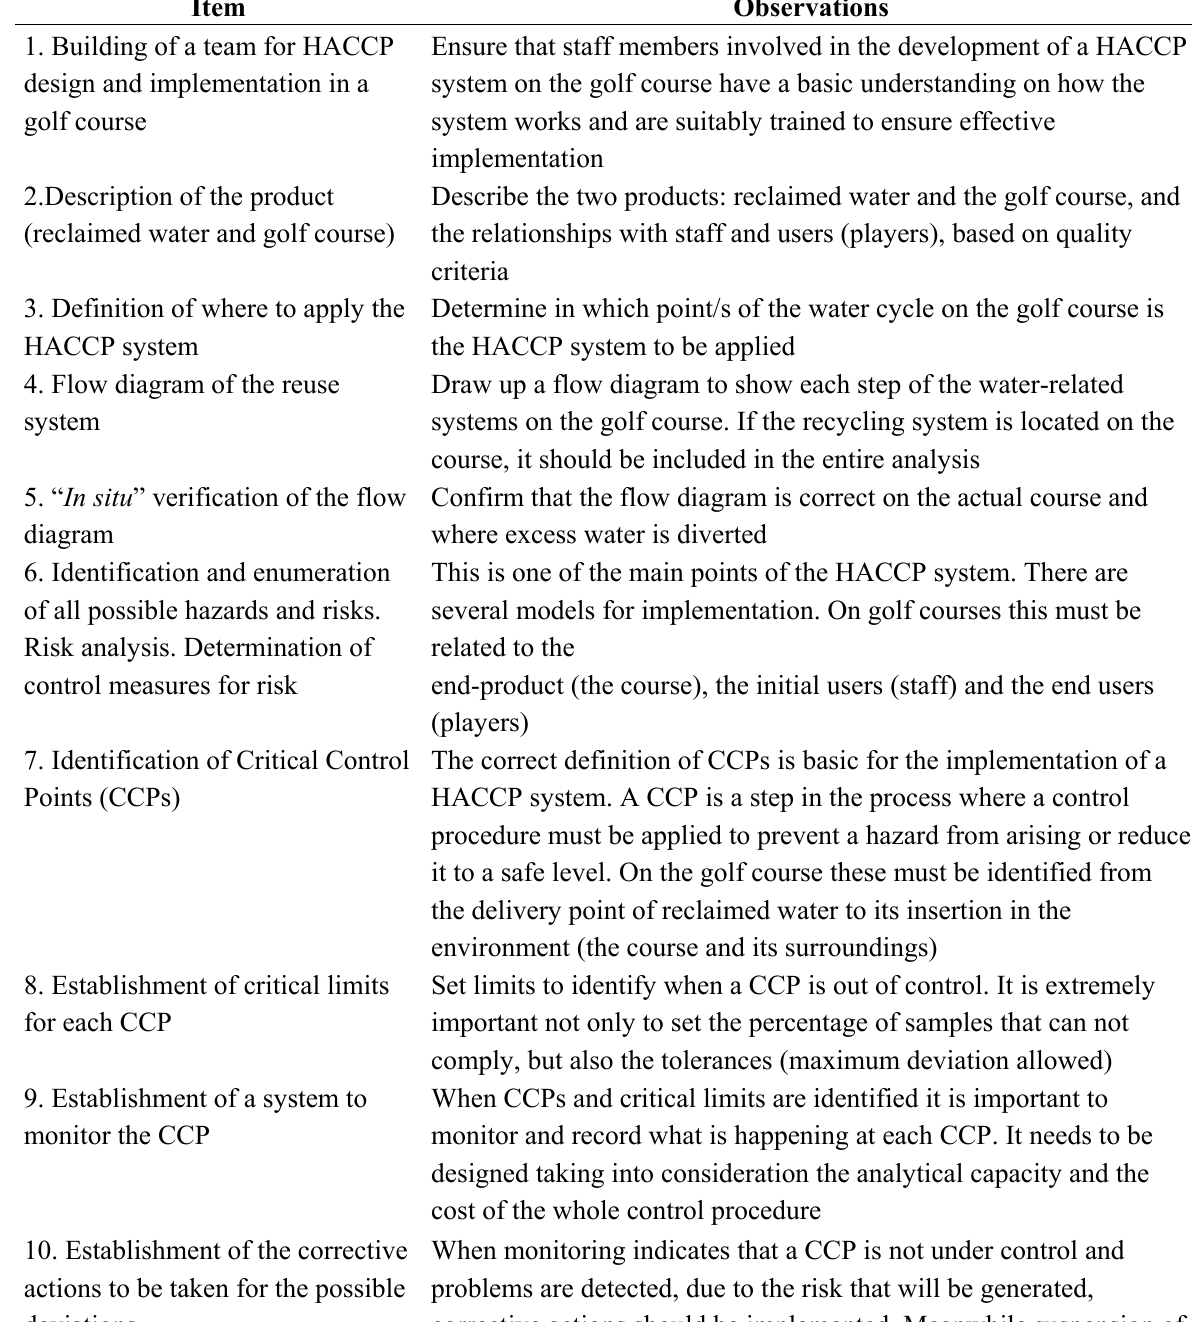
Table 15. Logical sequence for implementation of a HACCP plan